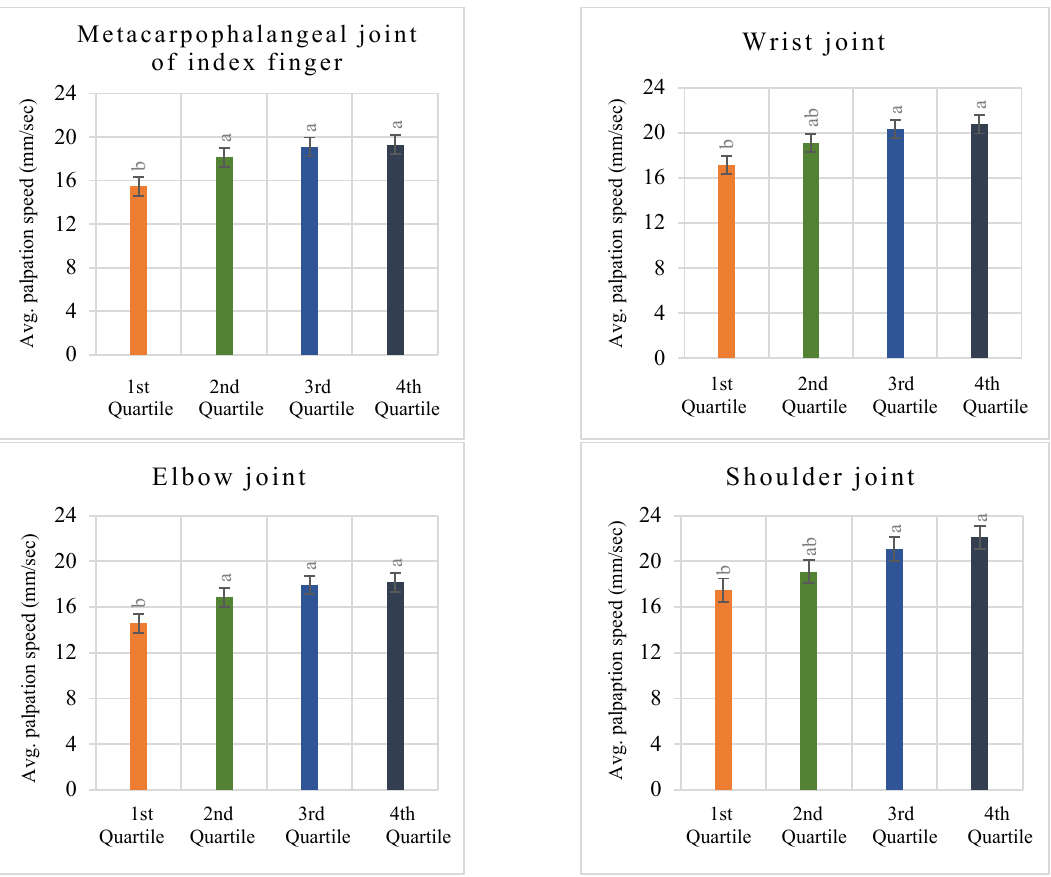
Figure 9. Average palpation speeds on standard stiffness side in quarterly subsets of total number of trials (mean ± standard error). Means labeled without a common letter are significantly different ( p <